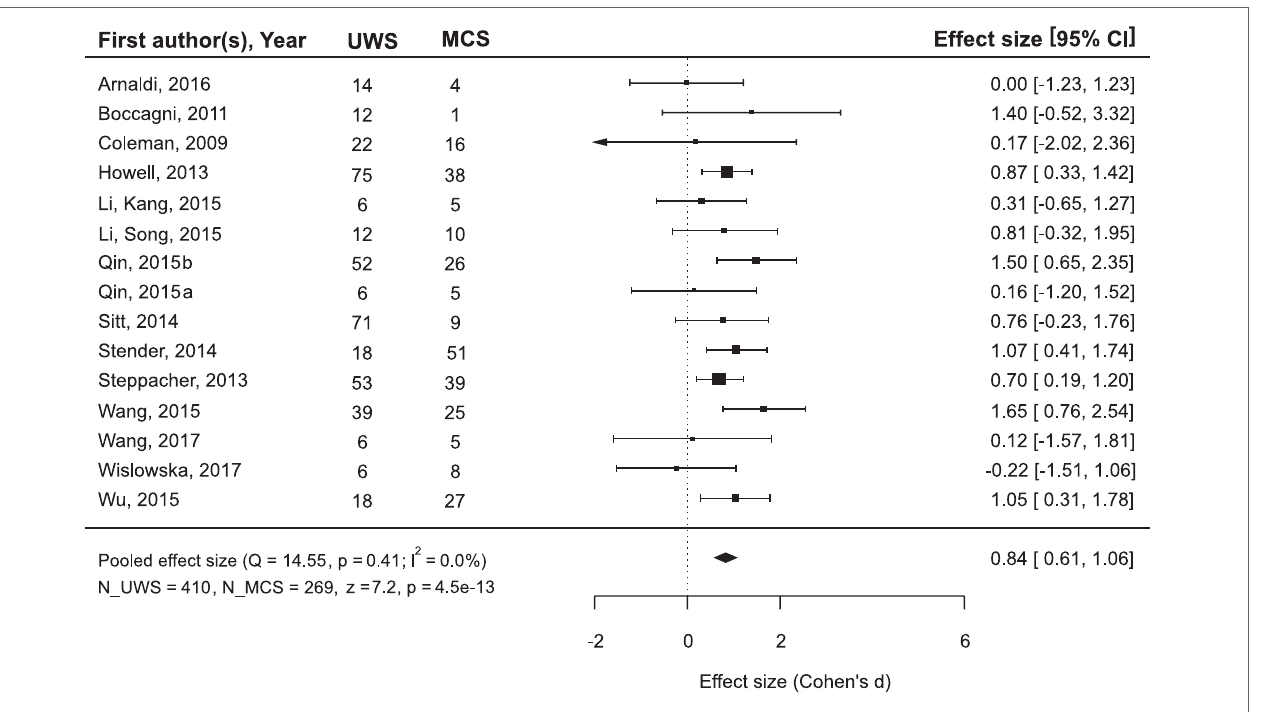
FiguRe 3 | The results of the meta-analysis for prediction of the outcome from the diagnosis. The criterion of improvement for all patients was recovery of full consciousness. Q , the corresponding p -value and I 2 are estimates of between-study heterogeneity; symbols ■ stay for the estimates of effect size (ES) in each single study, with the size of the symbol being proportional to the precision of the estimate. Error bars indicate the 95% confidence intervals of ES. The diamond ♦ is the estimate of the overall effect, the edges of the diamond represent the 95% confidence interval limits; CI, confidence interval; UWS and MCS, sample size of UWS and MCS patients in individual studies; N_UWS and N_MCS, overall sample size of the two patient groups. The resulting ES was tested for significance using z -criterion; the values of z and the corresponding p are given at the end of the lower left